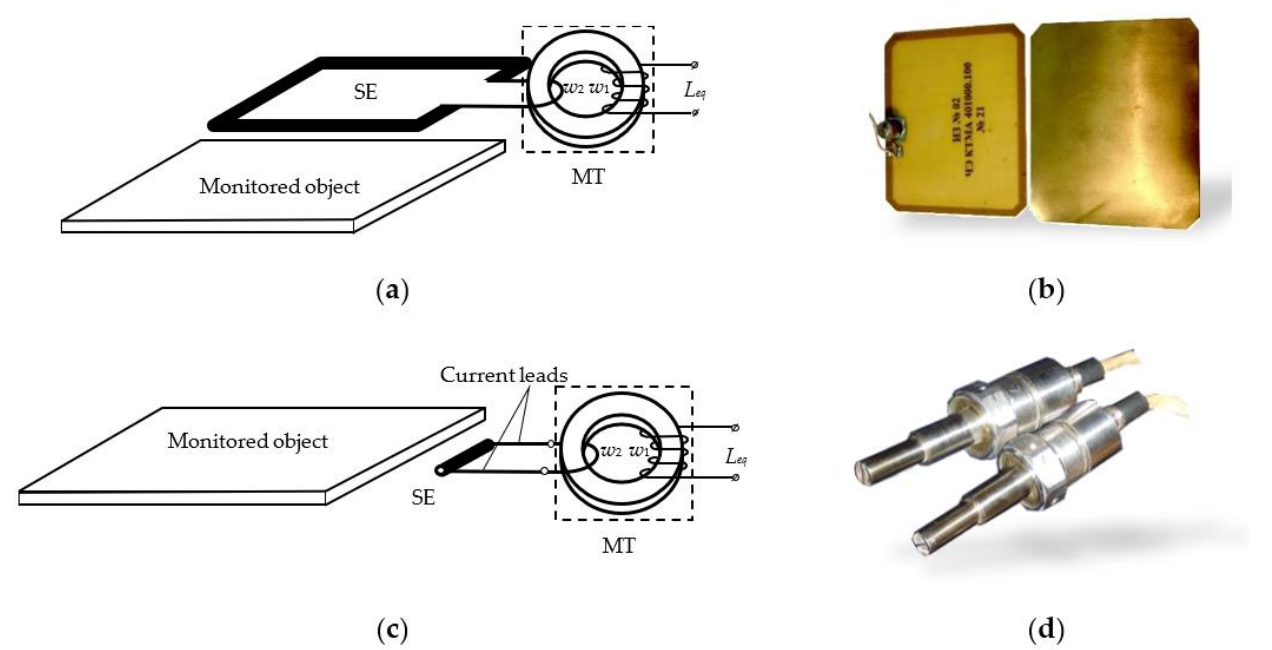
Figure 1. Schematic images ( a , c ) and the examples ( b , d ) of SCECS: the sensor with SE as a single current-carrying coil for measuring the gaps between the photocells of the adjacent flaps of the solar arrays ( a , b ) and the sensor with SE as a segment of a linear conductor for non-contact measuring of radial clearances in GTE compressor ( c , d ).